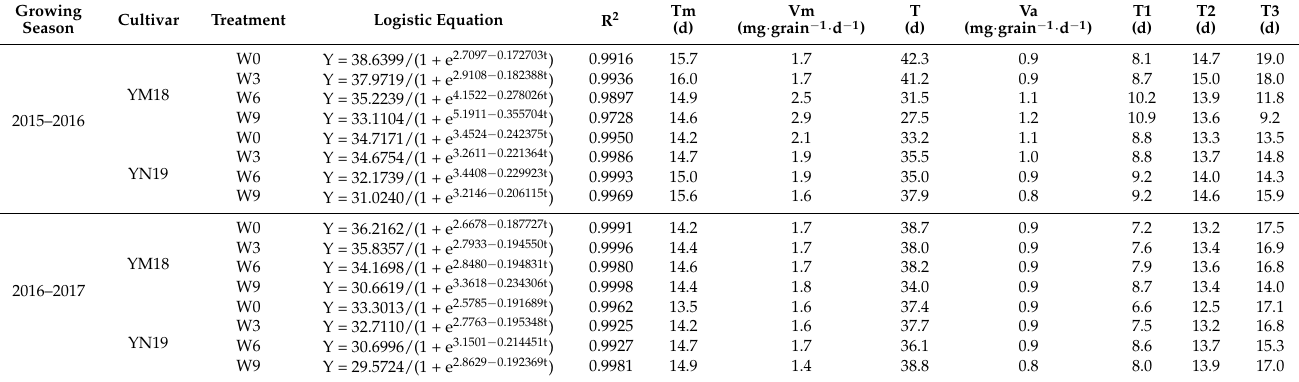
Table 3. Logistic equation and characteristic parameters of grain filling in different treatments. Growing Season Cultivar